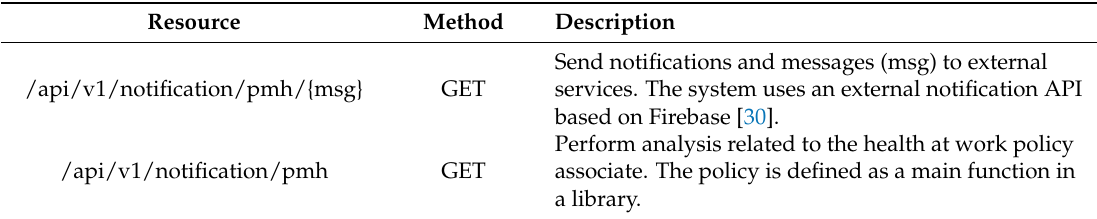
Table 6. Resources provided by the Analysis and Action Policy